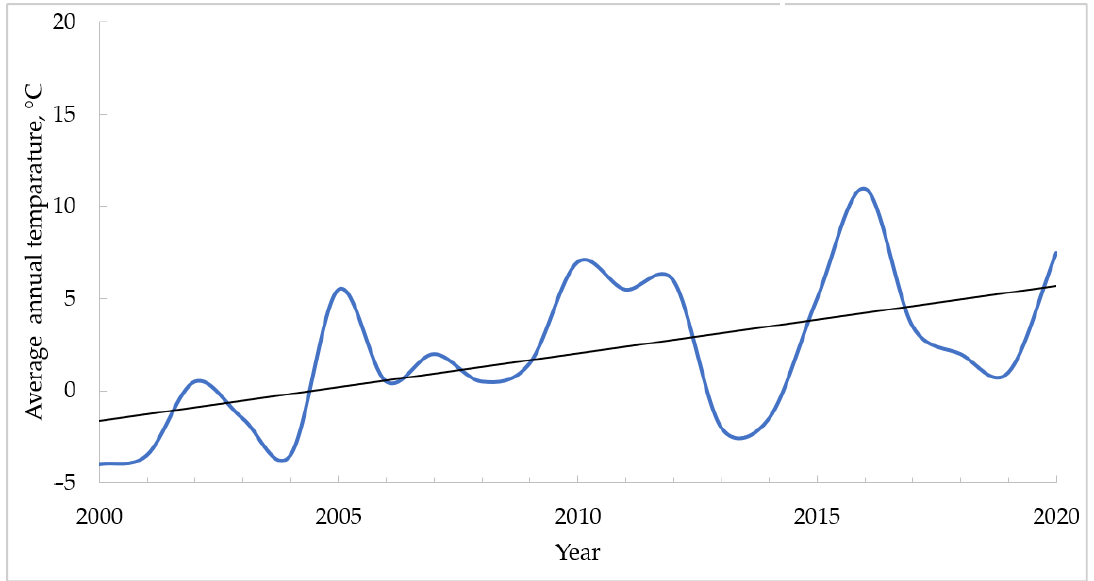
Figure 5. The average annual temperature of the bottom layer of the Kara Sea in the period 1999–2020 (blue line) and the trend line (black) (based on data from [50]).